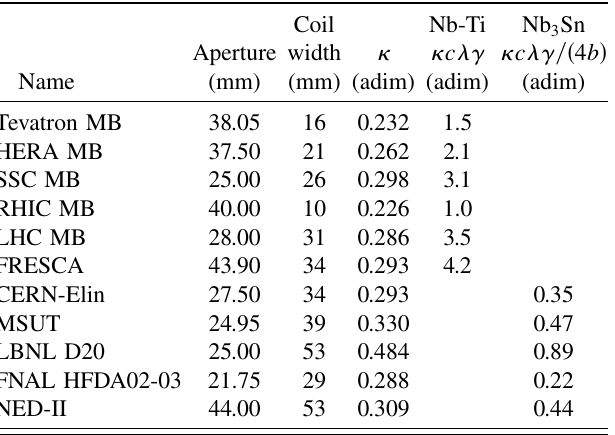
TABLE II. Current/field limited factors for Nb-Ti and Nb for some superconducting dipoles.